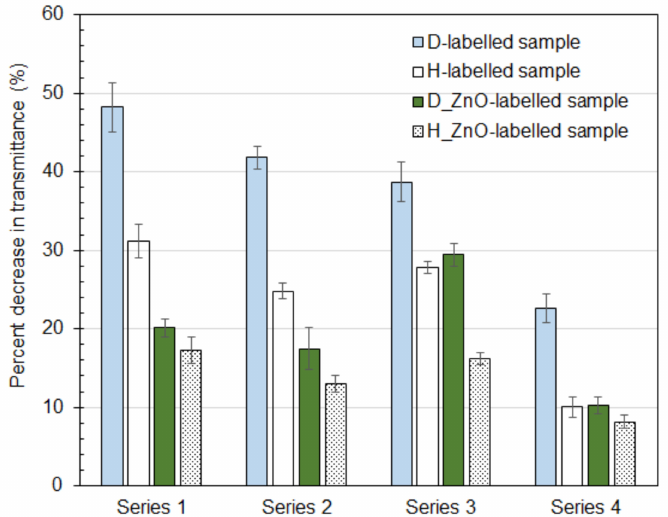
Figure 8. Water whitening of coatings, expressed in terms of transmittance decrease. The water whitening was evaluated after a one-day exposition of coatings cast on glass panels in distilled water. Transmittance values were measured at 500